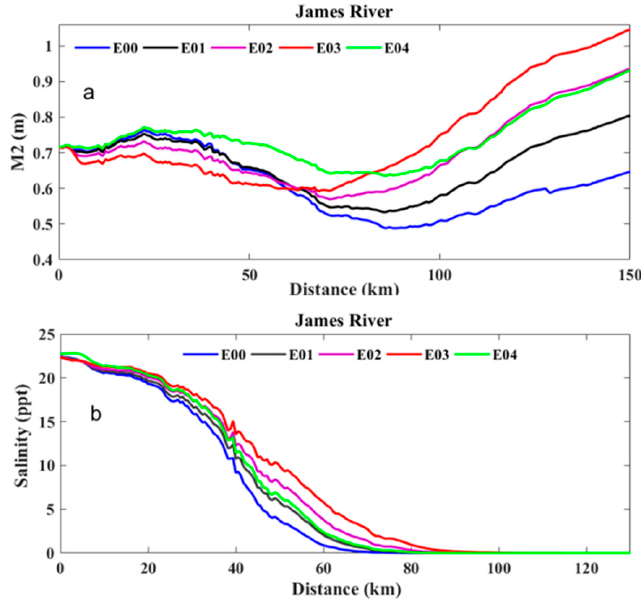
Figure 3. Modeled M 2 tide range and annual mean salinity along the channel under present, channel deepening, and future sea-level conditions. ( a ) Tidal range; ( b ) Salinity intrusion.